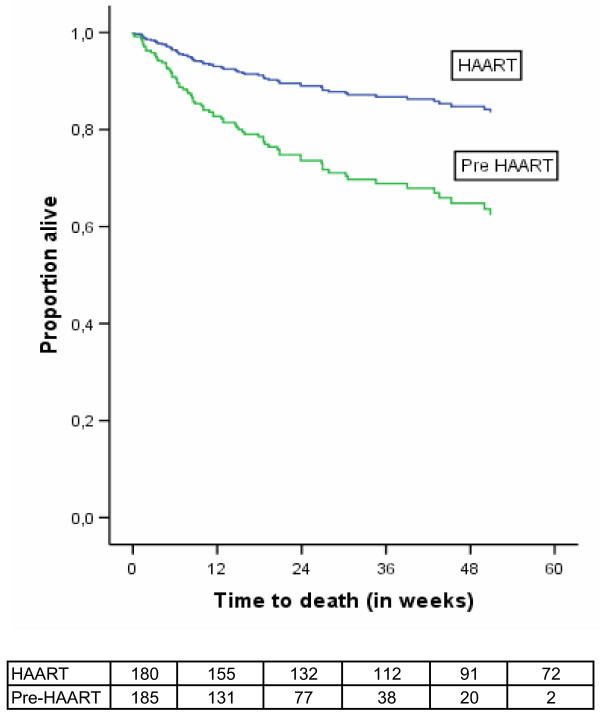
Survival curve according to adjusted Cox regression analysis shown in Table 3.